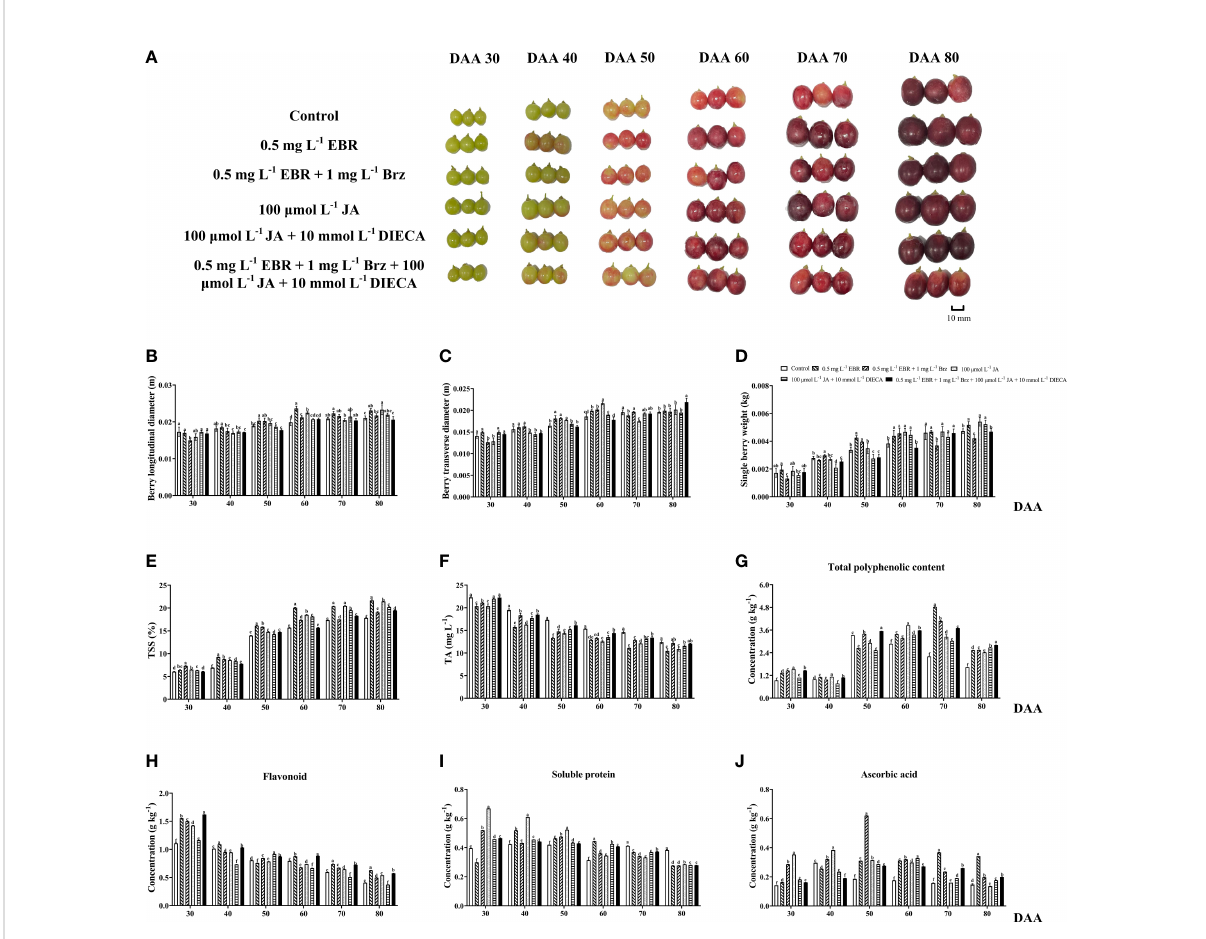
FIGURE 1 Grape berry phenotypes and berry quality-related parameters. (A) Grape berries were collected in six treatment groups (Control, 0.5 mg L -1 EBR, 100 m mol L -1 JA, 0.5 mg L -1 EBR + 1 mg L -1 Brz, 100 m mol L -1 JA + 10 mmol L -1 DIECA, 0.5 mg L -1 EBR + 1 mg L -1 Brz + 100 m mol L -1 JA + 10 mmol L -1 DIECA) at six sampling stages (DAA 30, 40, 50, 60, 70, 80). (B-J) Effect of exogenous EBR, JA and their signaling inhibitors on grape berry quality in different treatment groups (Control, 0.5 mg L -1 EBR, 100 m mol L -1 JA, 0.5 mg L -1 EBR + 1 mg L -1 Brz, 100 m mol L -1 JA + 10